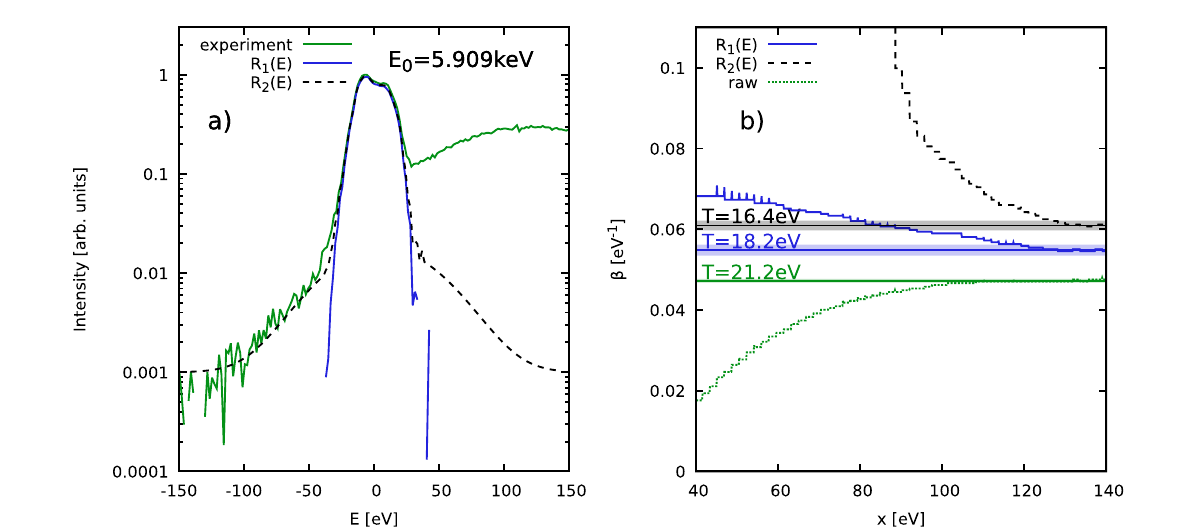
Fig.4|Temperaturediagnosisofwarmdensegraphite.a XRTSmeasurementby Kraus et al. 27 (green) and possible SIFs R 1 ( E ) (blue) and R 2 ( E ) (dashed black) shown on a semi-logarithmic scale; b Convergence of our model-free temperature S ( q , E ) via Eq. (1). The results are shown as the red squares, where the upper integration range is denoted as b shown on the top abscissa.